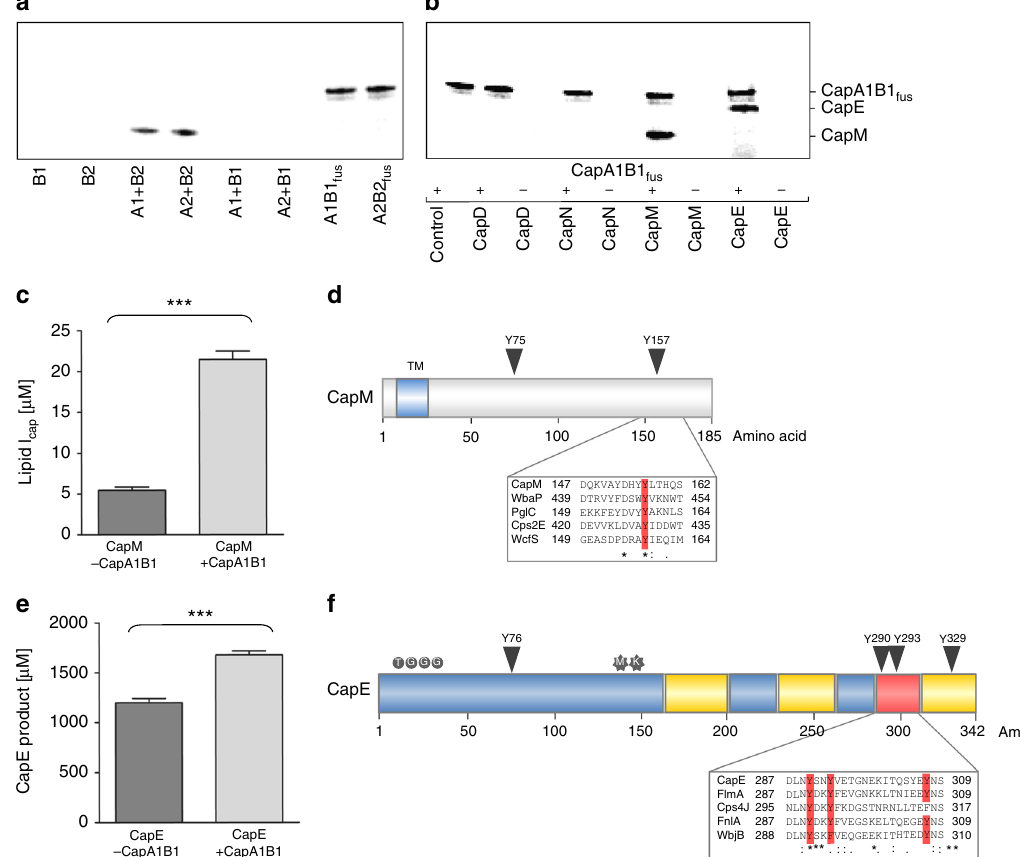
Fig. 3 Tyrosine phosphorylation positively controls CapM and CapE activity. a CapAB autokinase activity was assayed in the presence of [ 33 P]ATP using either native proteins or kinase activator CapA1 and tyrosine kinase CapB1 fused into a single polypeptide (CapA1B1 fus ). Phosphotransfer was analyzed by SDS-PAGE and phosphoimaging. b CapM and CapE are phosphorylated by the CapA1B1 fus tyrosine kinase complex. Putative target proteins (3 µ g) were assayed for phosphotransfer in the presence and absence of CapA1B1 fus . CapA1B1 fus , 50.2 kDa; CapB2, 25.3 kDa; CapE, 38.6 kDa; CapD, 69.1 kDa; CapM, 21 kDa; CapN, 33.7 kDa. c Impact of CapA1B1 kinase activity on CapM glycosyltransferase activity. CapM was incubated in presence of either active CapA1B1 (light grey) or heat-inactivated CapA1B1 (dark grey) with UDP- D -[ 14 C]FucNAc and C 55 P. After extraction with BuOH/PyrAc, reactions were analyzed by TLC and phosphoimaging. d Topology and CapAB phosphorylation site (arrow) of CapM. The protein is anchored in the membrane by one reentrant transmembrane domain. The catalytic domain is located in the cytoplasm. Sequence alignment of homologous proteins containing the conserved Tyr phosphorylation site (red) is boxed. (from top to bottom: S. aureus , Salmonella enterica , Campylobacter concisus, Streptococcus pneumoniae and Bacteroides fragilis ). e Impact of CapA1B1 kinase activity on CapE-mediated substrate conversion. CapE was incubated in presence of either active CapA1B1 (light grey) or heat-inactivated CapA1B1 (dark grey) with UDP- D -GlcNAc. Reactions were analyzed by CE. f Mapping of CapE phosphorylation sites. Tyr phosphorylation sites are marked by arrows. Cofactor binding site, substrate-binding site and the mobile loop are marked blue, yellow and red, respectively. The active site motif MxxxK (stars) and the cofactor binding motif TGxxGxxG (circles) are highlighted. A sequence alignment of the mobile latch (red) of selected homologous proteins from different species is boxed (from top to bottom: S. aureus , Bacillus cereus , Streptococcus pneumoniae , Enterococcus faecium, Pseudomonas aeruginosa) . Experiments were performed in triplicate. The error bars represent the ± standard deviation (SD) from three biological replicates. Statistical signi fi cance was analyzed by an unpaired t test (*** p <